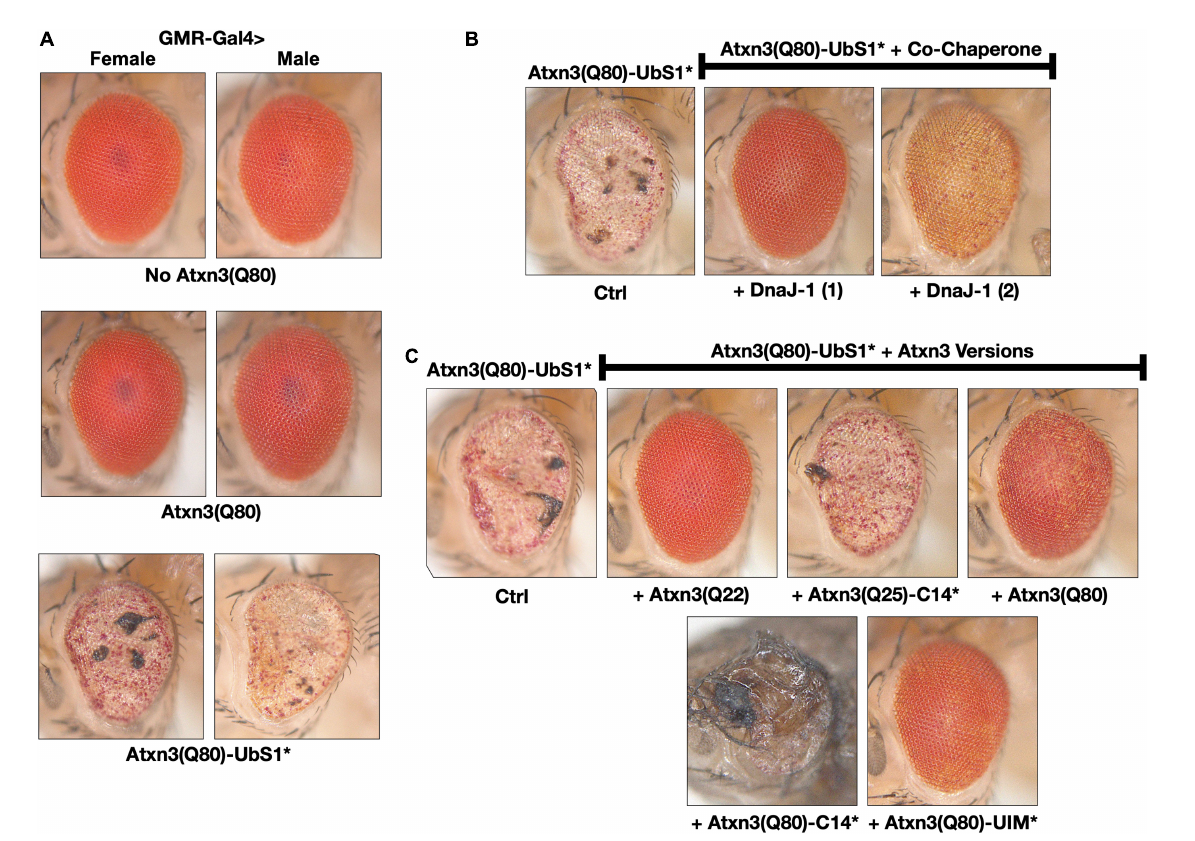
FIGURE3 Toxicity from Atxn3(Q80)-UbS1* in fly eyes is modulated by DnaJ-1 and catalytically active Atxn3. (A–C ) Images of external fly eyes expressing the noted transgenes. All flies were 1 day old. C14*: Mutated catalytic cysteine at position 14 into alanine to render Atxn3 catalytically inactive (Winborn et al., 2008). UIM*: Mutations in each of the ubiquitin-interacting motifs of Atxn3 to disable their interaction with ubiquitin chains (Winborn et al., 2008; Todi et al., 2009). Q(n): Length of the polyQ, where 22 and 25 denote wild-type range and 80 denotes disease